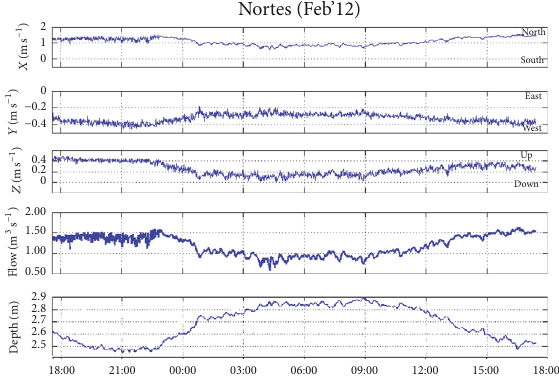
Figure 2: Direction, velocity, and flux in X’Buya-Ha spring during the Nortes season (Feb 2012). The 𝑥 -axis shows 24 hours of observation from 18:00 on 2/12/12.